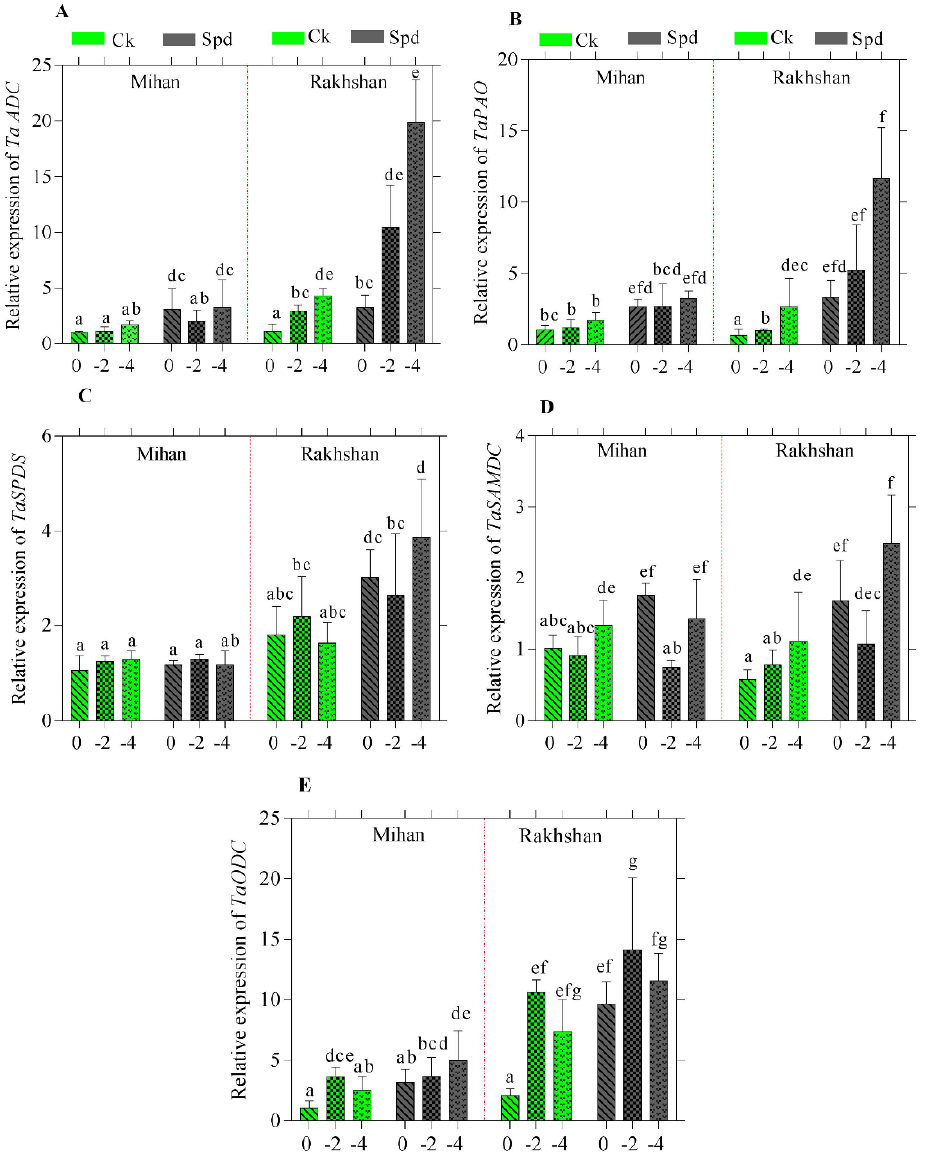
Figure 9. Effect of drought stress (0, − 2 and − 4 MPa) with Spd and Ck (control) in radicle of wheat genotypes (Mihan and Rakhshan) on relative expression of arginine decarboxylase ( TaADC ) ( A ), polyamine oxidase ( TaPAO ) ( B ), spermidine synthase ( TaSPDS ) ( C ), S-adenosylmethionine decar- boxylase ( TaSAMDC ) ( D ) and ornithine decarboxylase ( TaODC ) ( E ) genes determined by qRT-PCR. All reactions for gene expression analyses were performed in triplicate using 3 biological and 3 tech- nical repetitions. Bars show mean ± standard deviation (SD). Different letters indicate statistically significant differences at p < 0.05 level using LSD’s test.